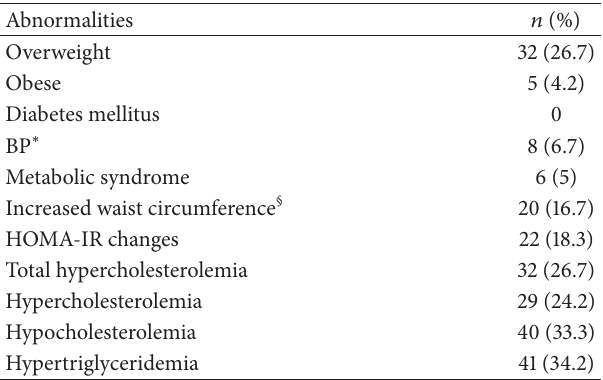
Table 1: Frequency of clinical or laboratory abnormalities in the 120 child and adolescent users of risperidone assessed by the